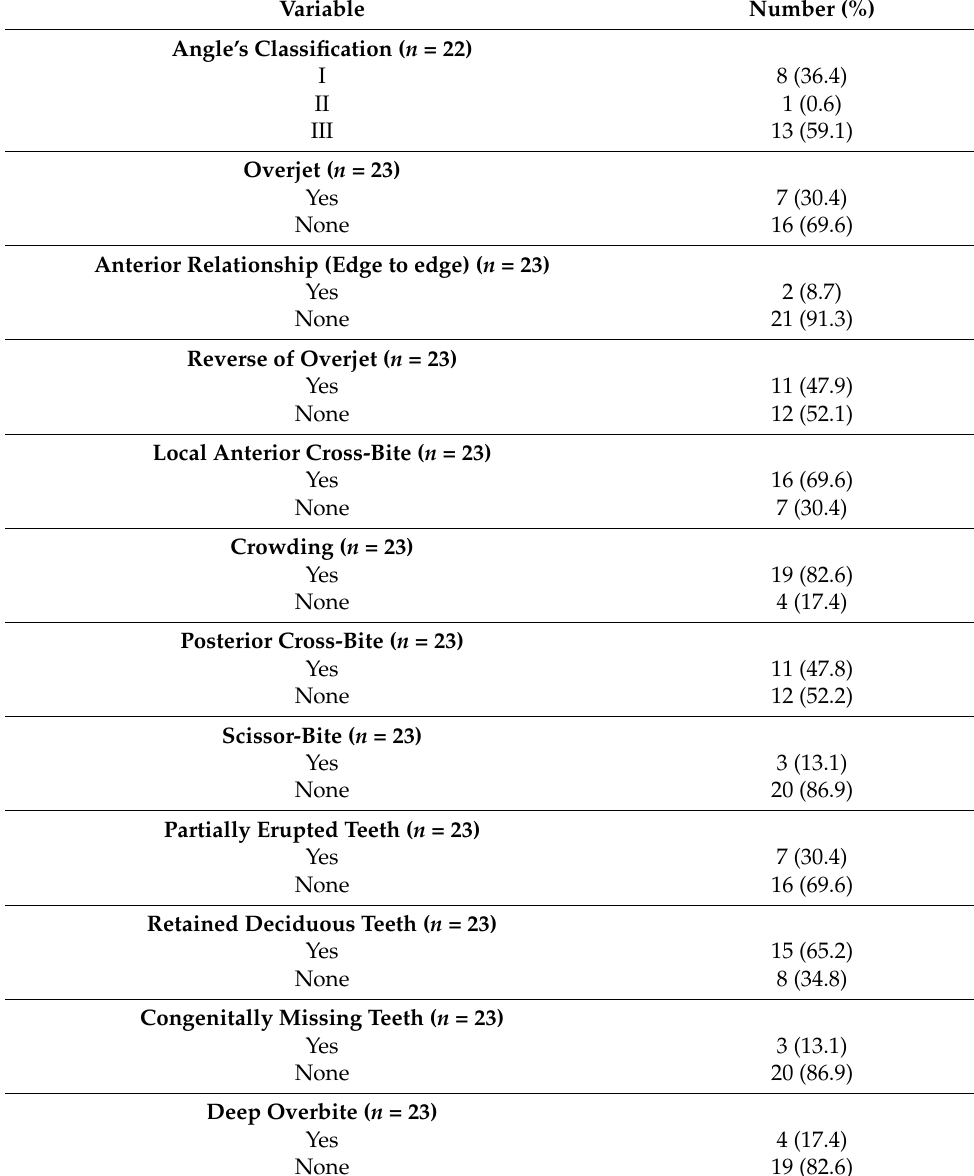
Table 2. Orthodontic Assessment